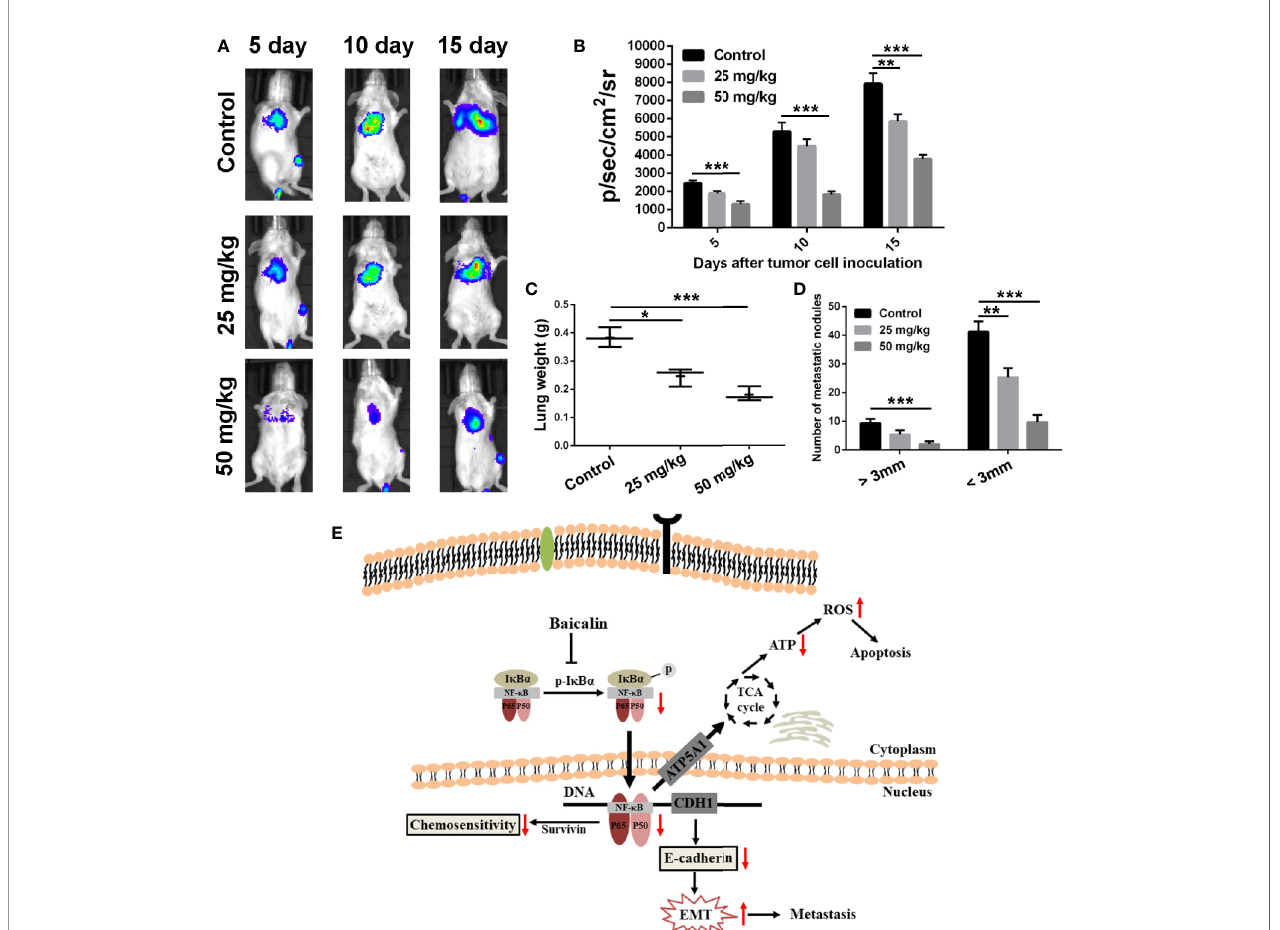
FIGURE 6 | BA inhibited pulmonary metastasis of breast cancer cells. Female Balb/c mice were intravenously injected with 5 × 10 5 4T1-Luciferase cells suspended in 100 m l of culture medium containing no FBS or antibiotics to establish pulmonary metastasis tumor mouse model. Five days after inoculation, the mice were intraperitoneally injected with vehicle, 25 mg/kg, or 50 mg/kg of BA every 2 days. (A) Bioluminescent images of mice of different treated groups at determined times. (B) Statistical analysis of bioluminescent signals of mice of different treated groups at determined times. (C) Lungs weight of mice in different treated groups at the termination of animal experiment. (D) Numbers of metastatic nodules (>3 mm and <3 mm) in lung tissues were counted at the termination of animal experiment. (E) Overview of pathways for baicalin-mediated anti-tumor effects on breast cancer cells. Baicalin induced apoptosis, inhibited metastasis, and enhanced chemosensitivity by NF- k B signaling pathway in breast cancer cells. Signi fi cant differences are indicated as follows: * P < 0.05; ** P < 0.01; *** P <